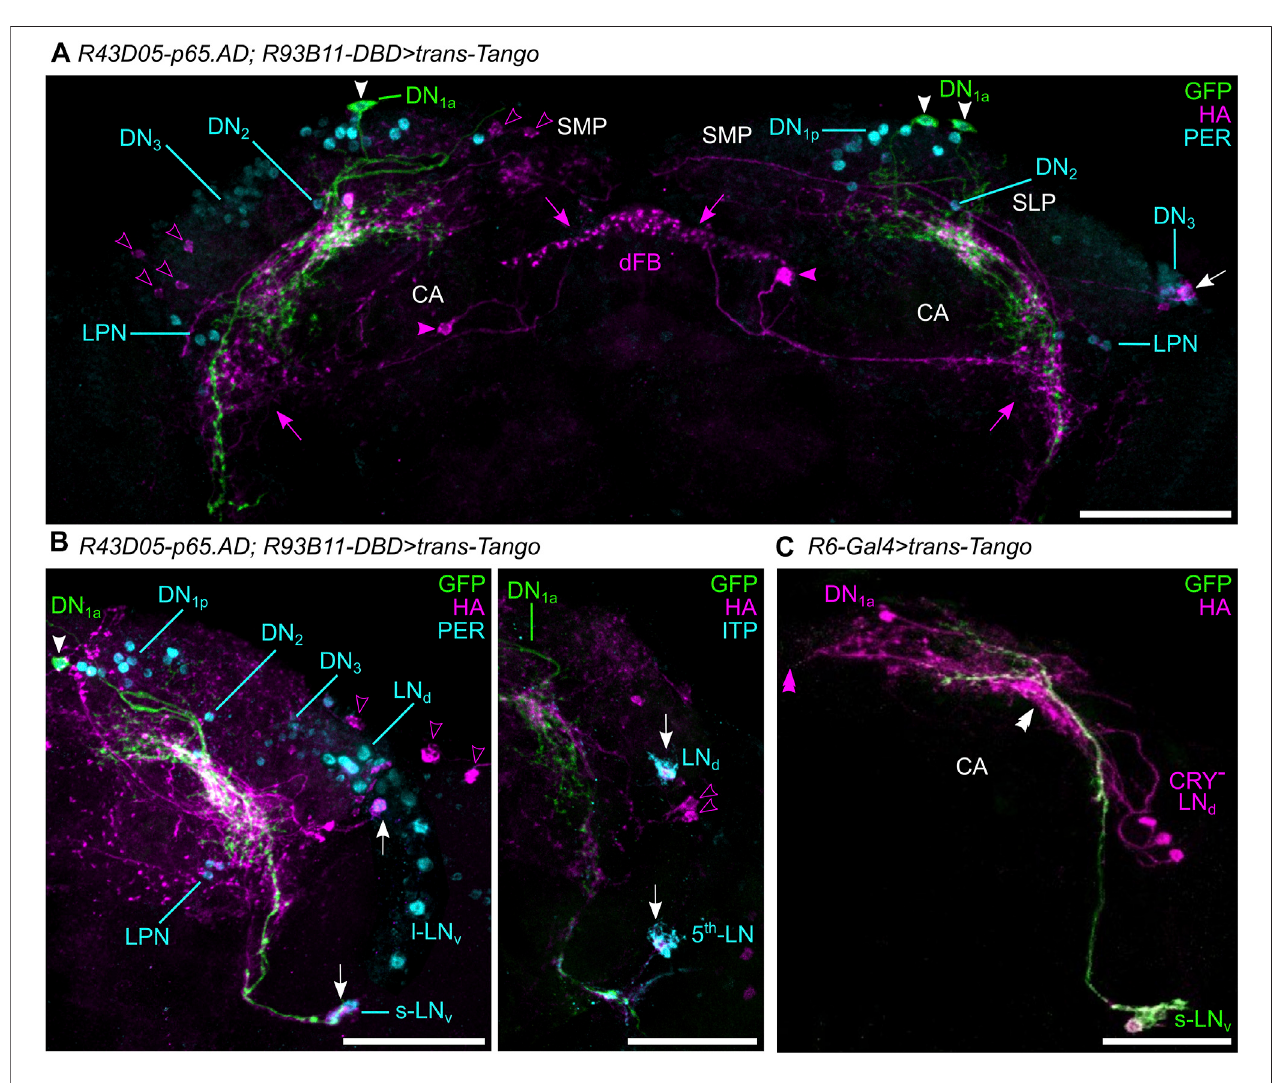
FIGURE 3 | Neurons pre- and postsynaptic to the DN 1a s revealed by trans -Tango. (A) Maximal projections of 30 confocal planes depicting a frontal view of the anterior part of the dorsal protocerebrum with the presynaptic DN 1a s marked in green (green fl uorescent protein, GFP), their postsynaptic partners in magenta (hemagglutinin, HA), and other clock neurons marked in cyan (labeled with anti-PER). One to two DN 3 clock neurons were labeled by HA and are consequently postsynaptic to the DN 1a s (white arrow). HA additionally labeled unknown postsynaptic neurons (open magenta arrowheads) in the superior medial (SMP) and the superiorlateral protocerebrum(SLP). Further, aneuron oftheeighthlayer ofthe fan-shaped body (FB)waslabeled aspostsynaptic totheDN 1a s(magentaarrowheads). Itinnervated notonlythedorsalFB(dFB)but alsotheposteriorlateralprotocerebrumatabouttheheightoftheLPNs(magentaarrows).Inthisregion,anetworkof fi bers postsynaptic of the DN 1a s is found that is adjacent to the dense varicose fi bers of the DN 1a s. (B) Maximal projection of 40 confocal planes depicting frontal views of the right lateral protocerebrum with the presynaptic DN 1a s labeled in green and their postsynaptic partners in magenta. In the left picture, all clock neurons are labeled by anti-PER in cyan, whereas in the right picture the ITP-positive clock neurons (LN d and fi fth LN) are labeled in cyan. White arrows point to clock neurons that are postsynaptic to the DN 1a s, Two s-LN v s and one LN d (left) and the ITP-positive fi fth LN and LN d (right). Note that in the brain shown to the left the l-LN v s and the fi fth LN d are located quite dorsally and cannotbe distinguished fromeach other. TheLN d sare also located moredorsallythanusuallyand overlap withtheDN 3 s. (C) Frontal view of the lateral protocerebrum with the presynaptic s-LN v s marked by GFP and their postsynaptic partners in magenta (maximal projection of 30 confocal planes). The